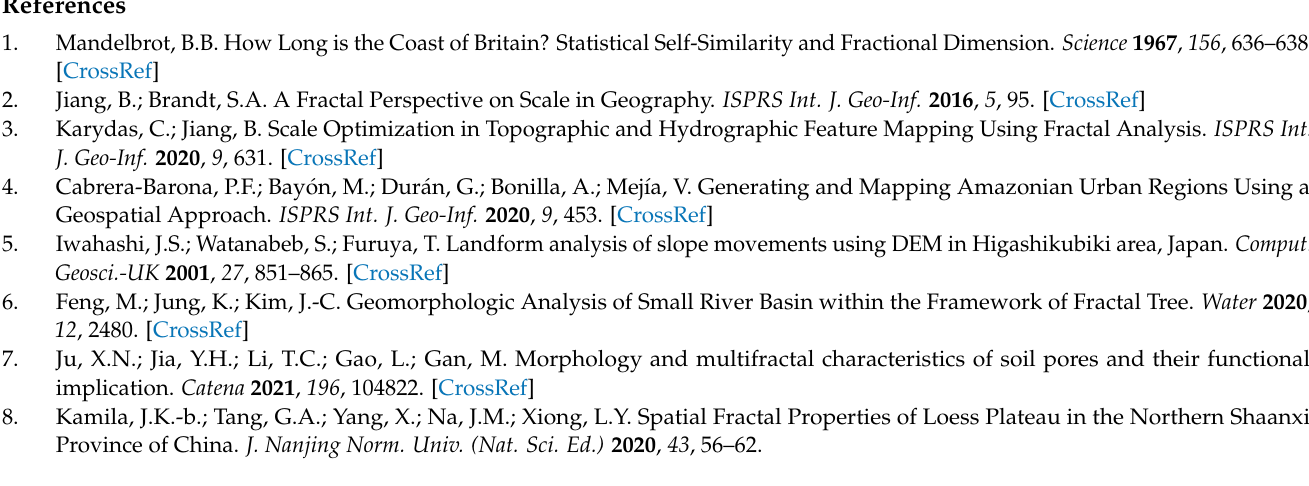
Figure A4. The relationship of ln 𝑀(𝑒, 𝑞) and ln 𝑒 in the Yellow River Downstream Basin. ( a ) The relationship of ln 𝑀(𝑒, 𝑞) and ln 𝑒 when e is [40,000, 50,000] and q is −3 0; ( b ) The relationship of ln 𝑀(𝑒, 𝑞) and ln 𝑒 when e is [40,000, 50,000] and q is 15.